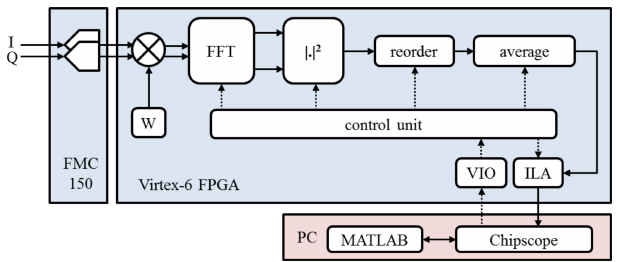
Figure 16. Block diagram for base-band processing for the sensing node.